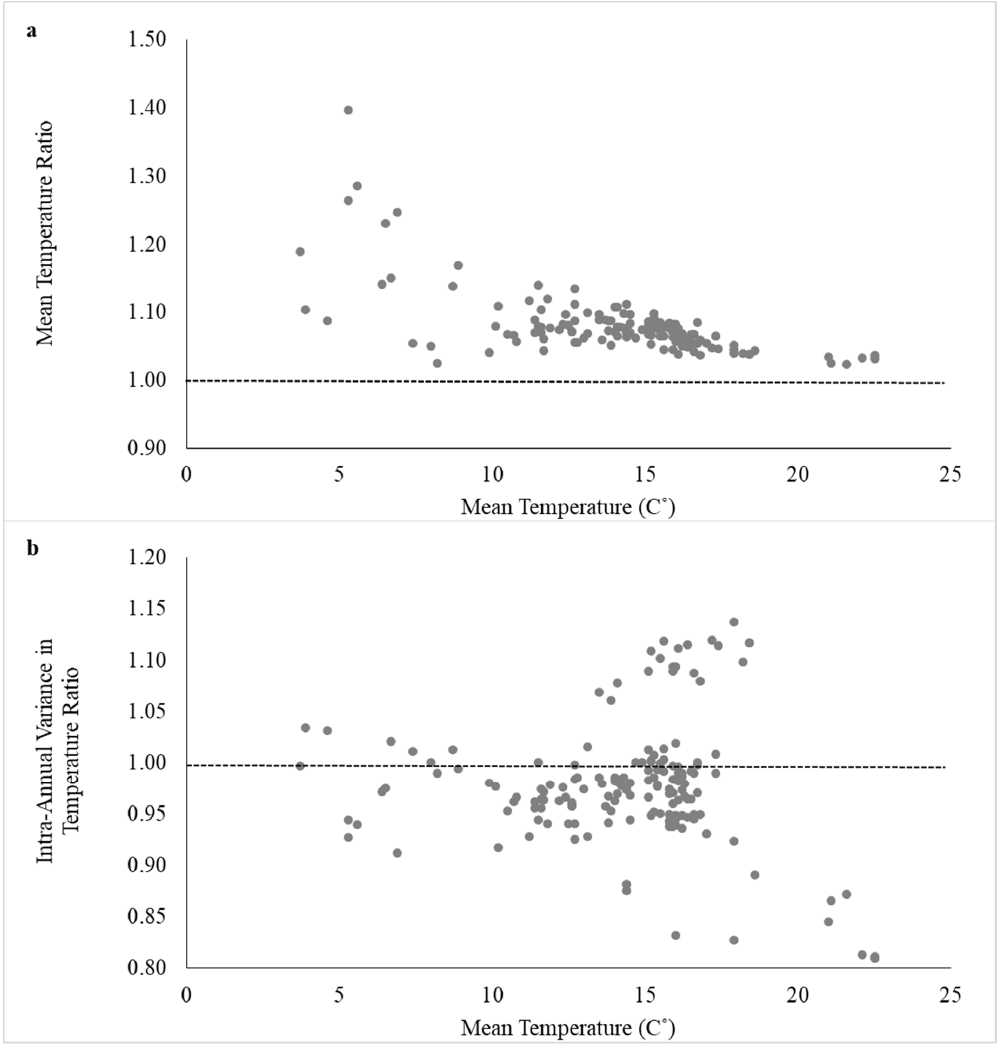
Figure 2. Temporal variation in climate (temperature) variables in the sample. ( a ) Ratio between observed and historical annual average temperature levels for each wastewater treatment plant with respect to historical annual average temperature levels; ( b ) Ratio between observed and historical intra-annual variation in temperature for each wastewater treatment plant with respect to historical intra-annual variation in temperature.